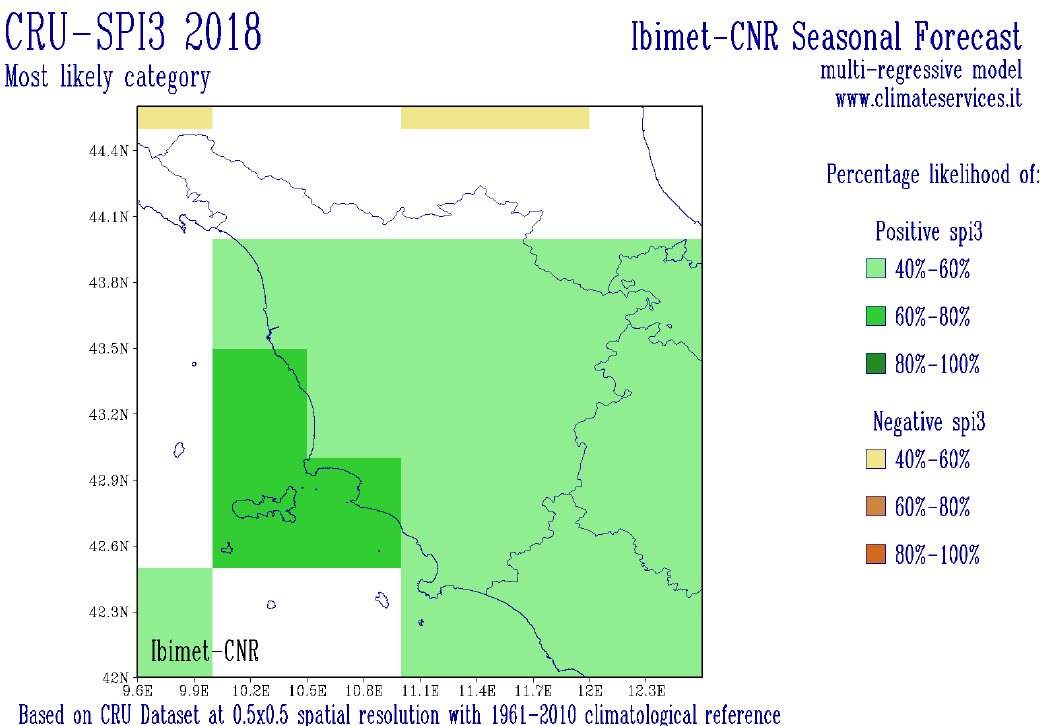
Figure 9. SPI 3 (Standardized Precipitation Index) seasonal forecast for winter 2018, where the 3 months are December 2017 and January–February 2018. February is the reference time stamp, and represents the last contributing month of the 3-month period. Color scale indicates the probability of occurrence of a wet (green) or dry (yellow–orange) period. The example shows a zoom on the Tuscany